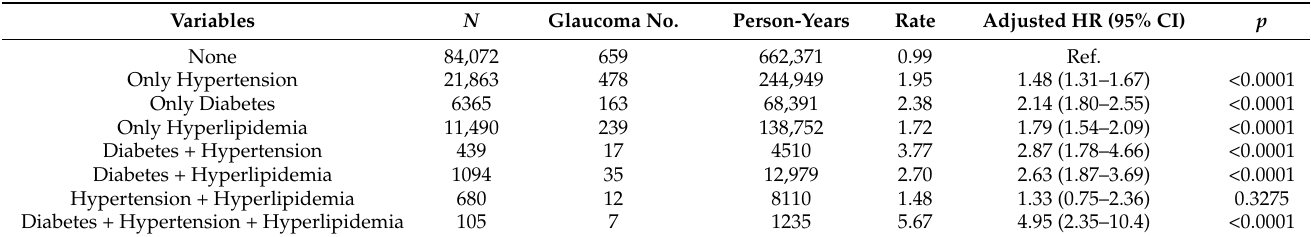
Table 3. Incidence and hazard ratio of glaucoma among patients with one or more components of metabolic disease.